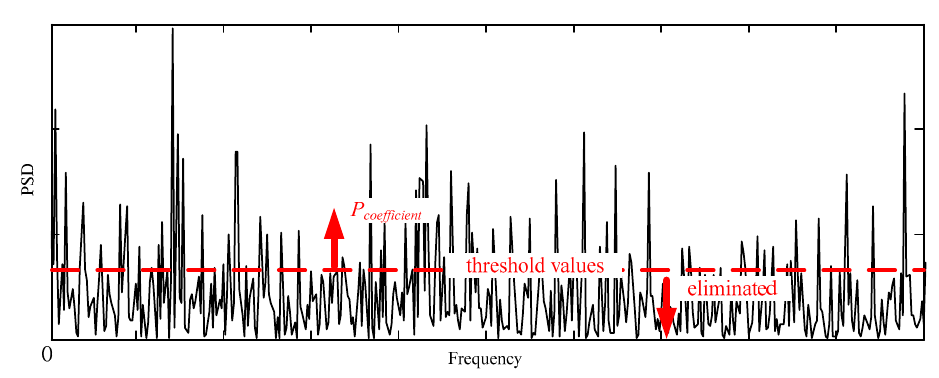
Figure 1. Demonstration of threshold processing.